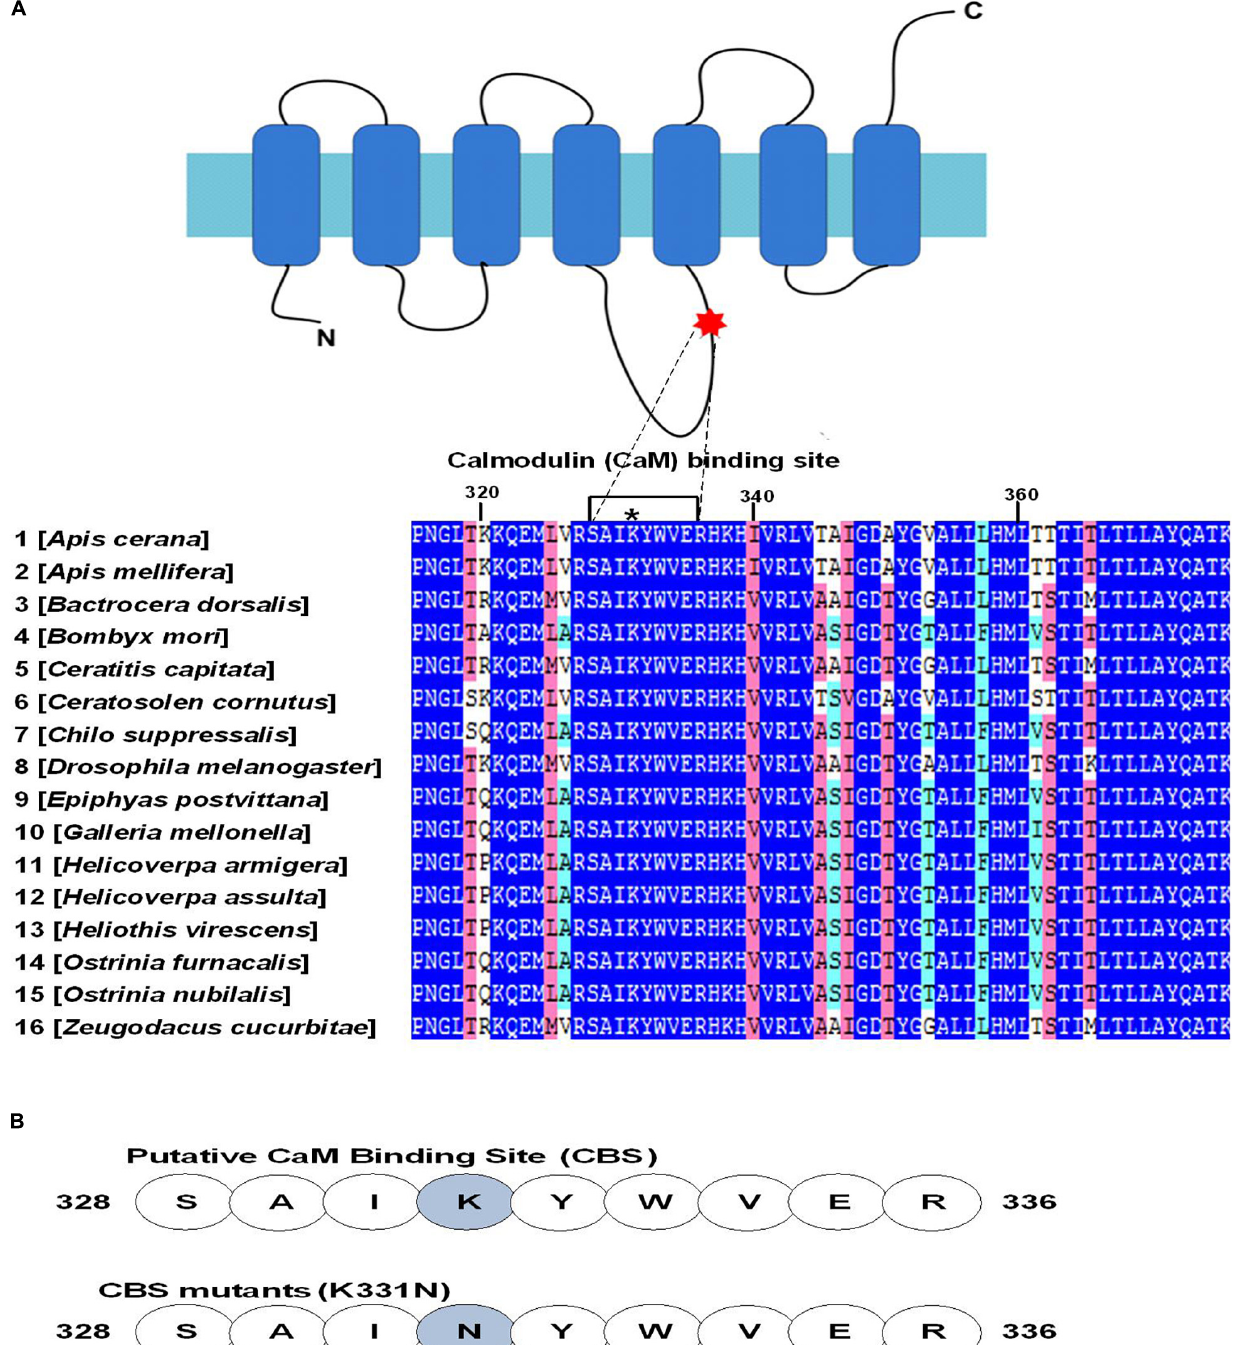
FIGURE 1 | Conservation of putative calmodulin (CaM) binding sites (CBSs) in the insect odorant co-receptor Orco. (A) Alignment of amino acids at the indicated position in the second intracellular loop of AcerOr2. The amino acids 328SAIKYWVER336 have a maximum score for the CBS and are highly conserved among various insect species. The asterisk indicates the position of the point mutation (K331N) introduced into the AcerOr2 CaM protein. The NCBI accession number for the Orco protein sequences are as follows: Apis cerana AET85154.3; Bactrocera dorsalis ACC86853.1; Bombyx mori NP_001037060.1; Ceratitis capitata NP_001266301.1; Ceratosolen cornutus ACU31808.1; Chilo suppressalis AFQ94048.1; Drosophila melanogaster AAT71306.1; Epiphyas postvittana ACJ12928.1; Galleria mellonella ALM30348.1; Helicoverpa armigera ADQ13177.1; Helicoverpa assulta ABU45983.2; Heliothis virescens CAD31851.1; Ostrinia furnacalis BAR43445.1; Ostrinia nubilalis BAJ23263.1; and Zeugodacus cucurbitae ADK97803.1. (B) Sequences of the AcerOr2 CBS and the location of the point mutation (K331N) introduced in the AcerOr2 CaM-binding mutant.